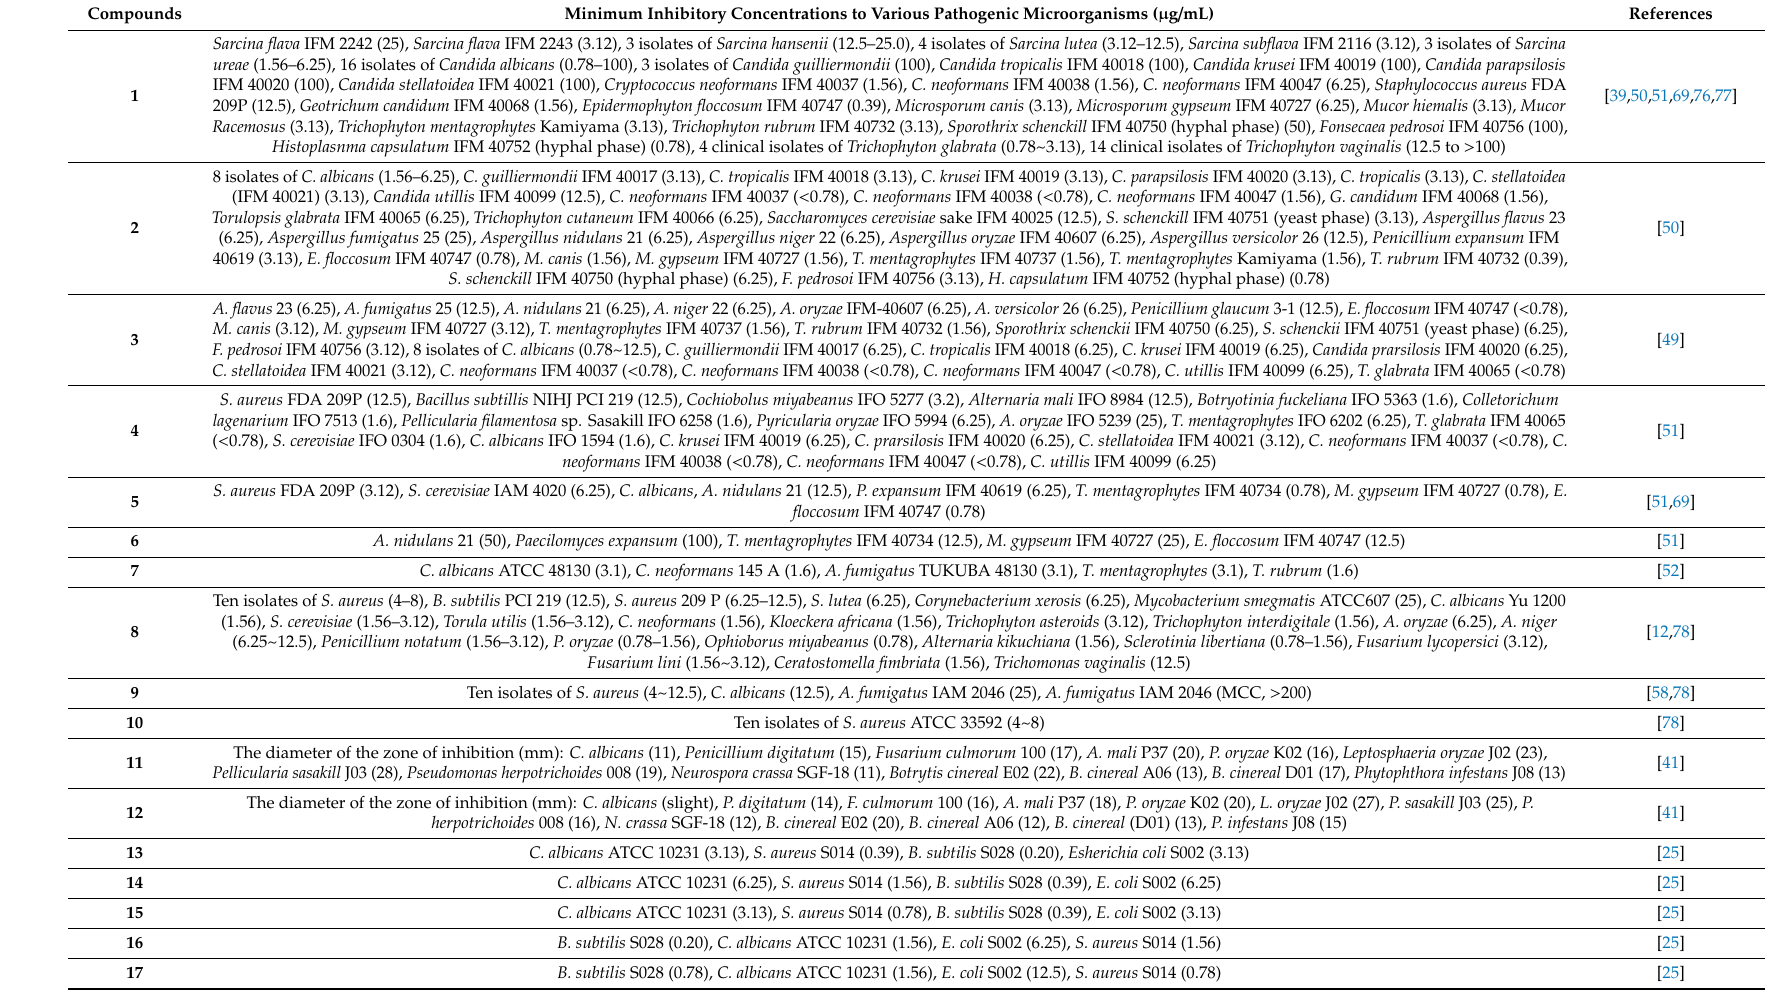
Table 3. Antibacterial activity of guanidyl-polyol macrolide